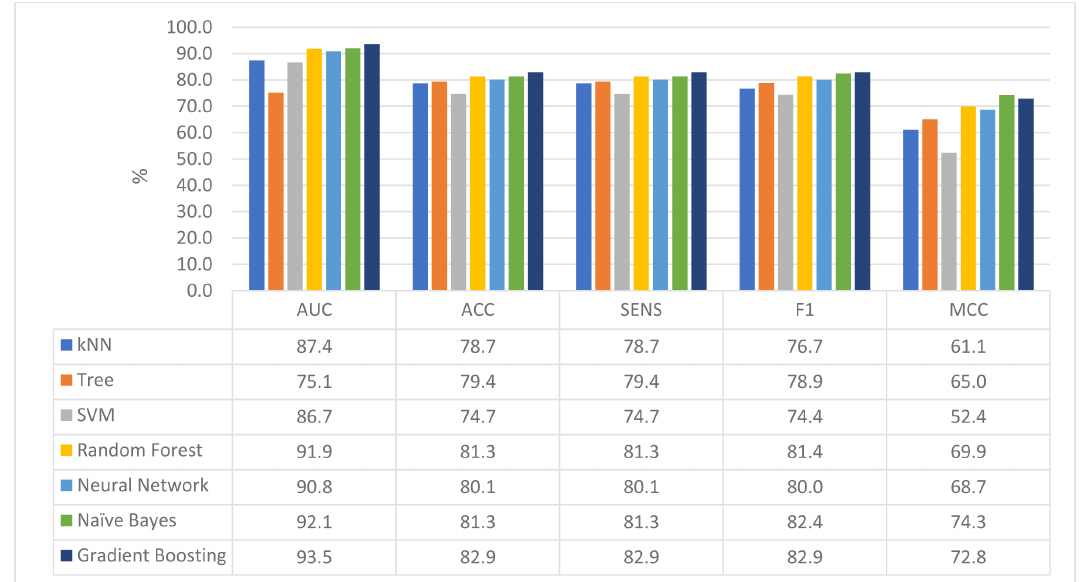
Figure 3. Evaluation of ML models performance analysis in predicting anxiety